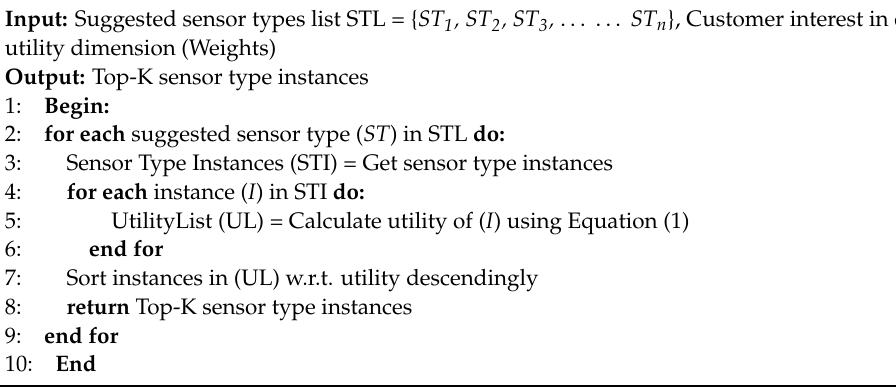
Algorithm 2 Utility-Based Sensor Type Instances